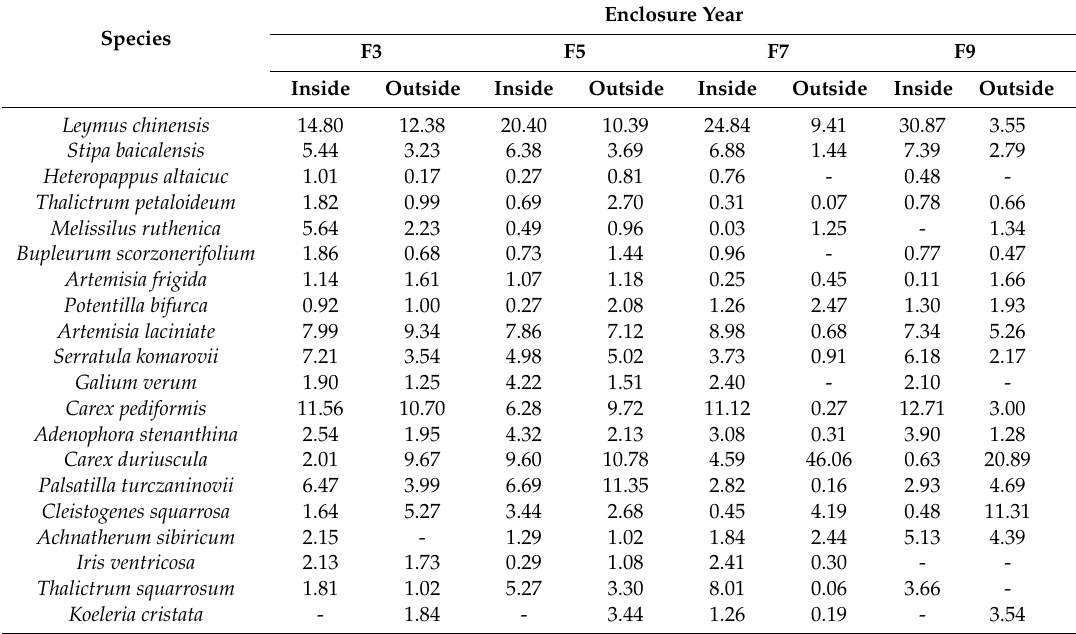
Table 1. The importance values of major plant species inside and outside the enclosure,